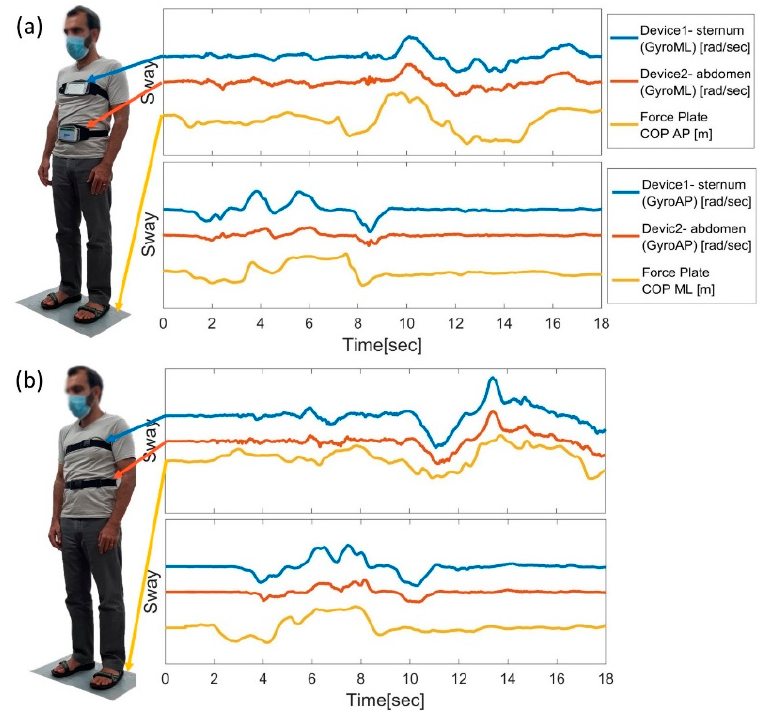
Figure 2. Mon4t vs. force plate (FP) raw signal comparison. Two methods captured the subject’s posture movement while standing in a neutral stance (NS) position. All graphs describe three normalized sensors for three different devices: Device 1 (blue), Device 2 (orange), and the FP (yellow). The two smartphones were placed on the subject’s ( a ) sternum and abdomen, or ( b ) on the upper and lower back, respectively.